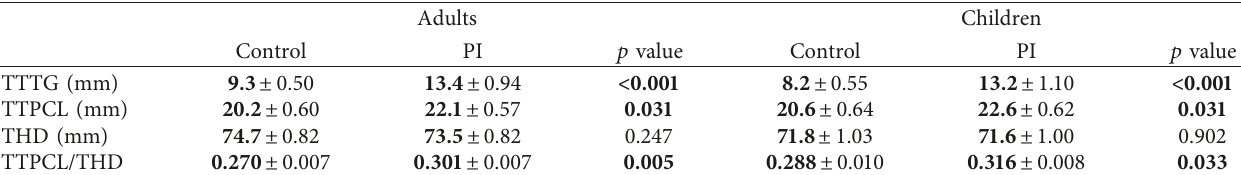
Table 2: Measurements of the TTTG, TTPCL, THD, and TTPCL/THD for the control and patellar instability (PI) groups for adults and children.